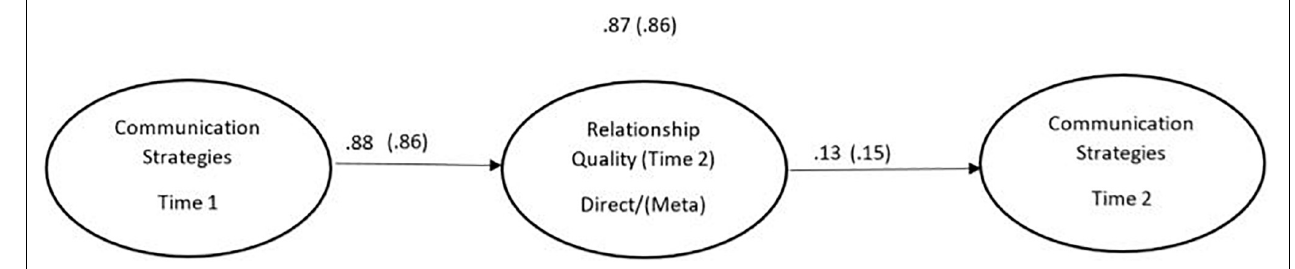
FIGURE 3 | The longitudinal model describing relationship quality at time 2 as a mediator between communication strategies at time 1 and communication strategies at time 2. Only standardized co-efficients are presented and both models (i.e., direct and meta) are presented in this figure for simplicity. Meta Perspective are presented in